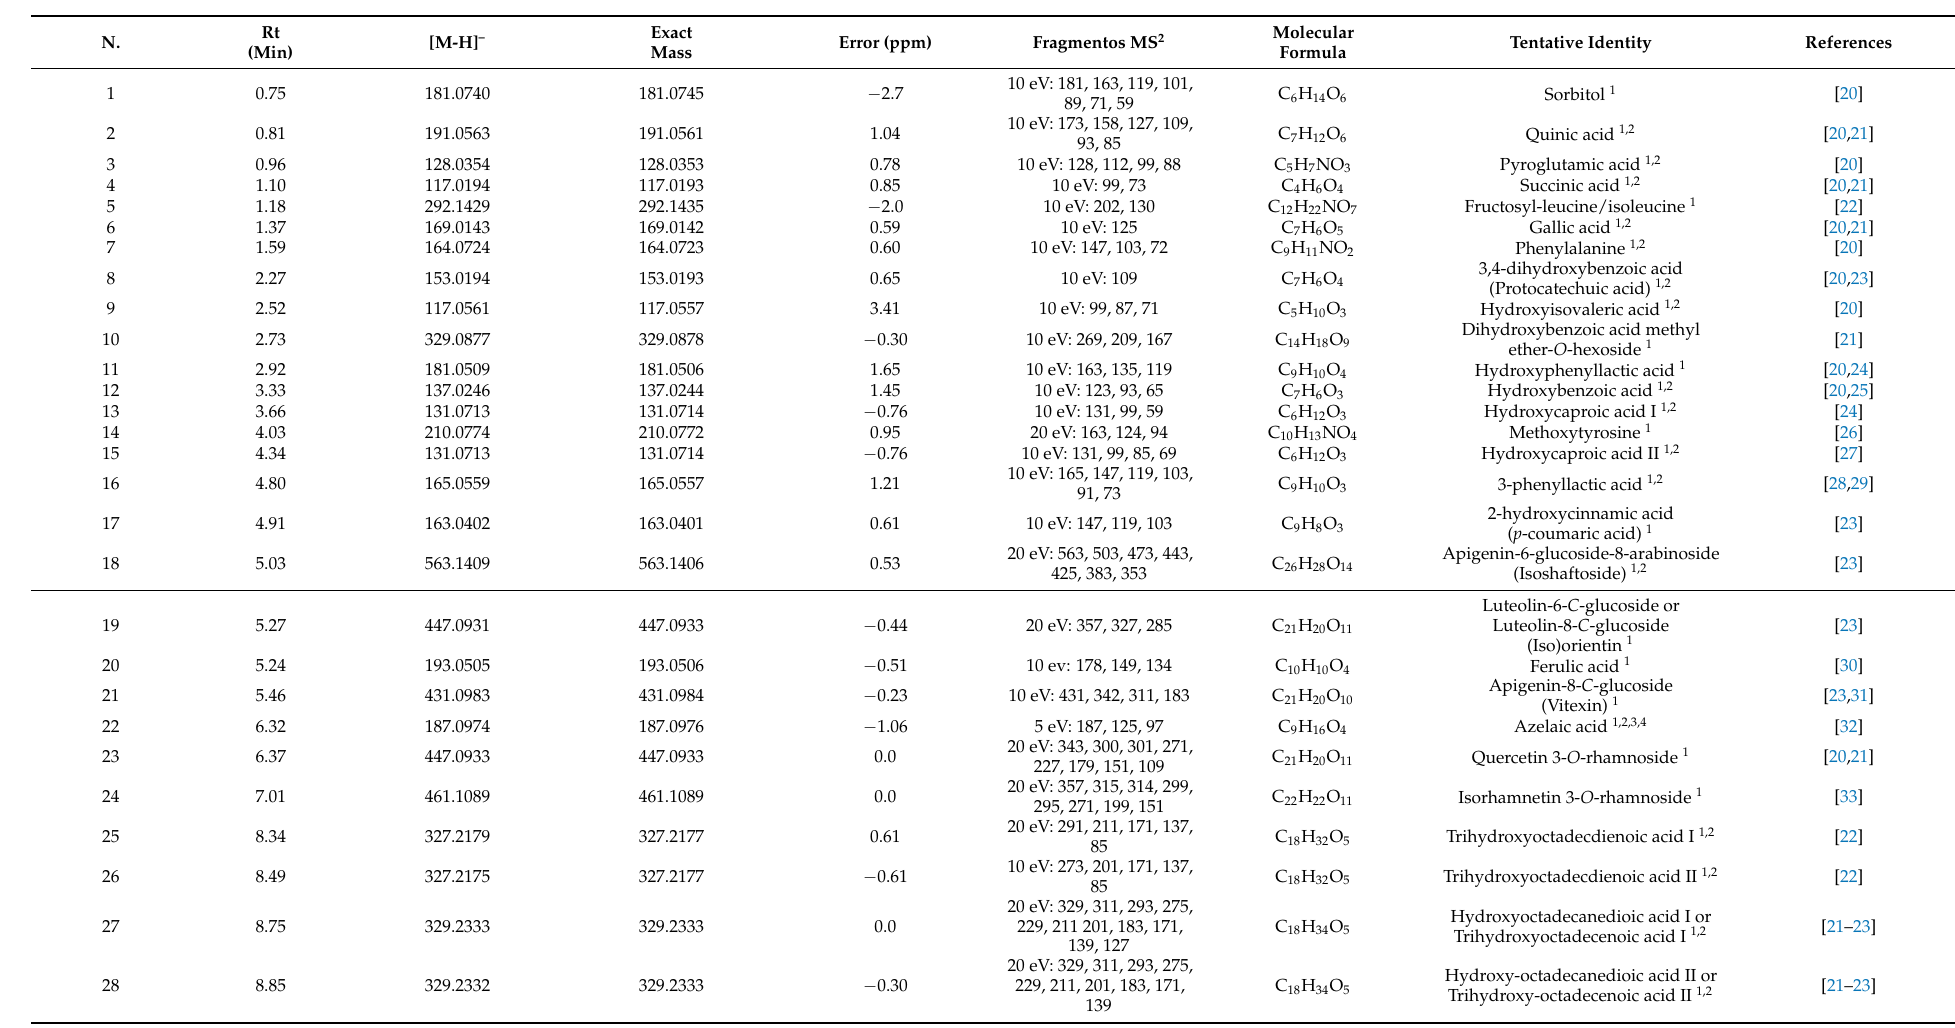
Table 3. Compounds identified in PPEE, PPHE, PSEE and PSHE by LC-MS in negative